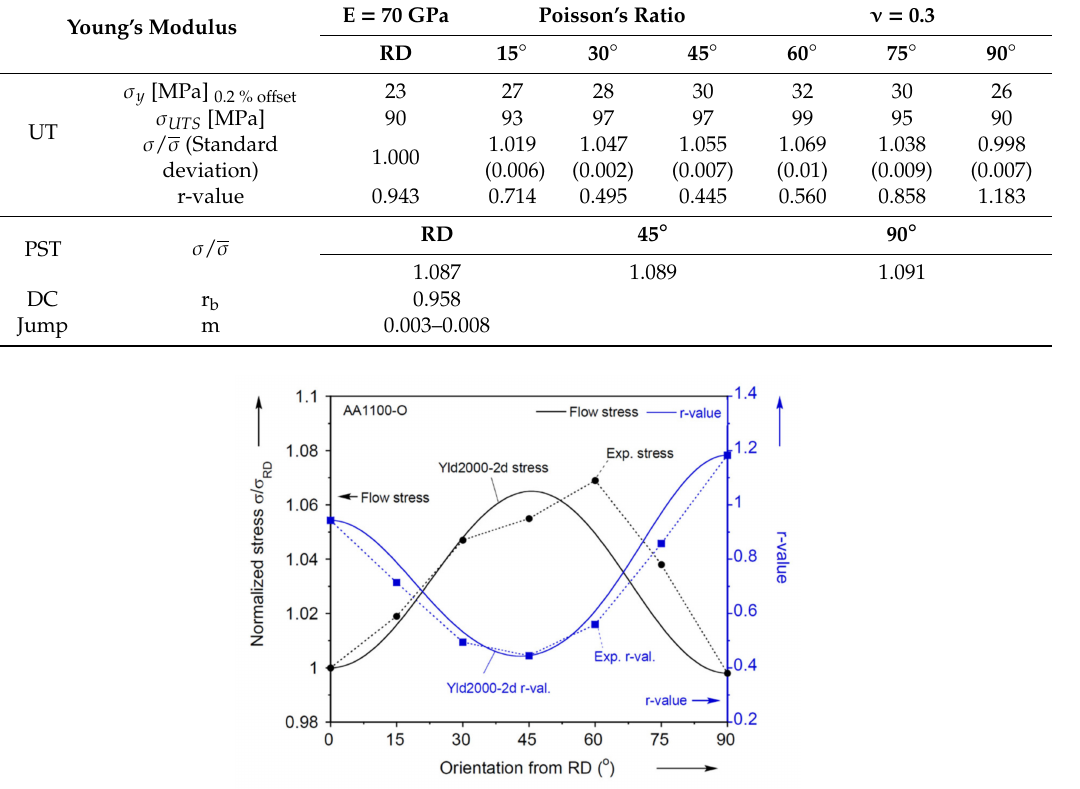
Figure 4. Anisotropy characterization in uniaxial tension in every 15 ◦ from the RD for flow stress and r-value. Prediction of Yld2000-2d is added to compare with the experiment.